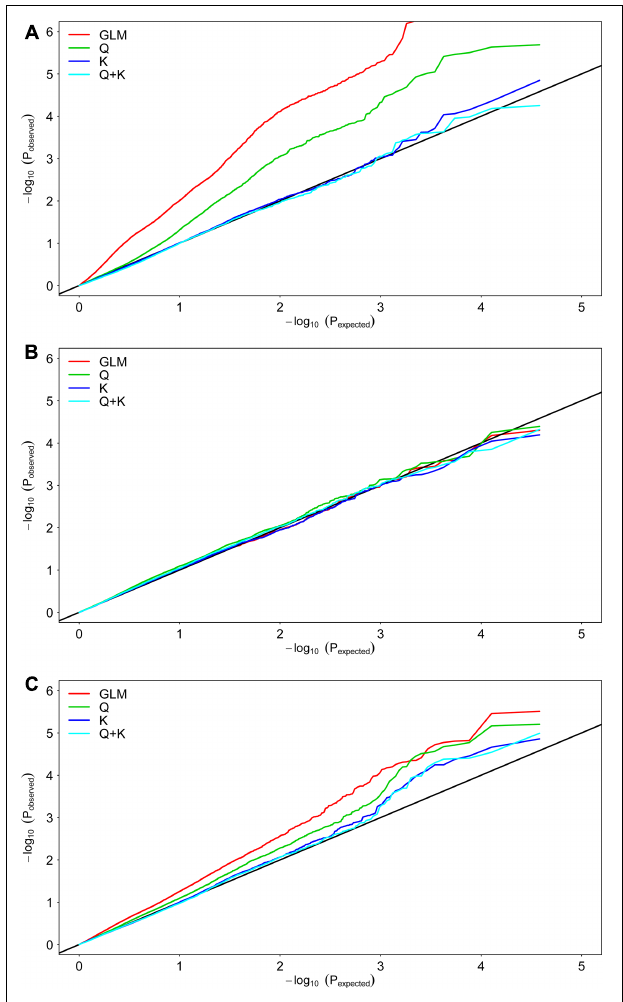
FIGURE 2 | Quantile–quantile plots of estimated –log10( P ) from association analysis of Cd accumulation traits in rapeseed accessions. (A) Root Cd concentration (RCC). (B) Shoot Cd concentration (SCC). (C) Cd translocation coefficient (CT). GLM considering no Q and K; Q, GLM considering Q;